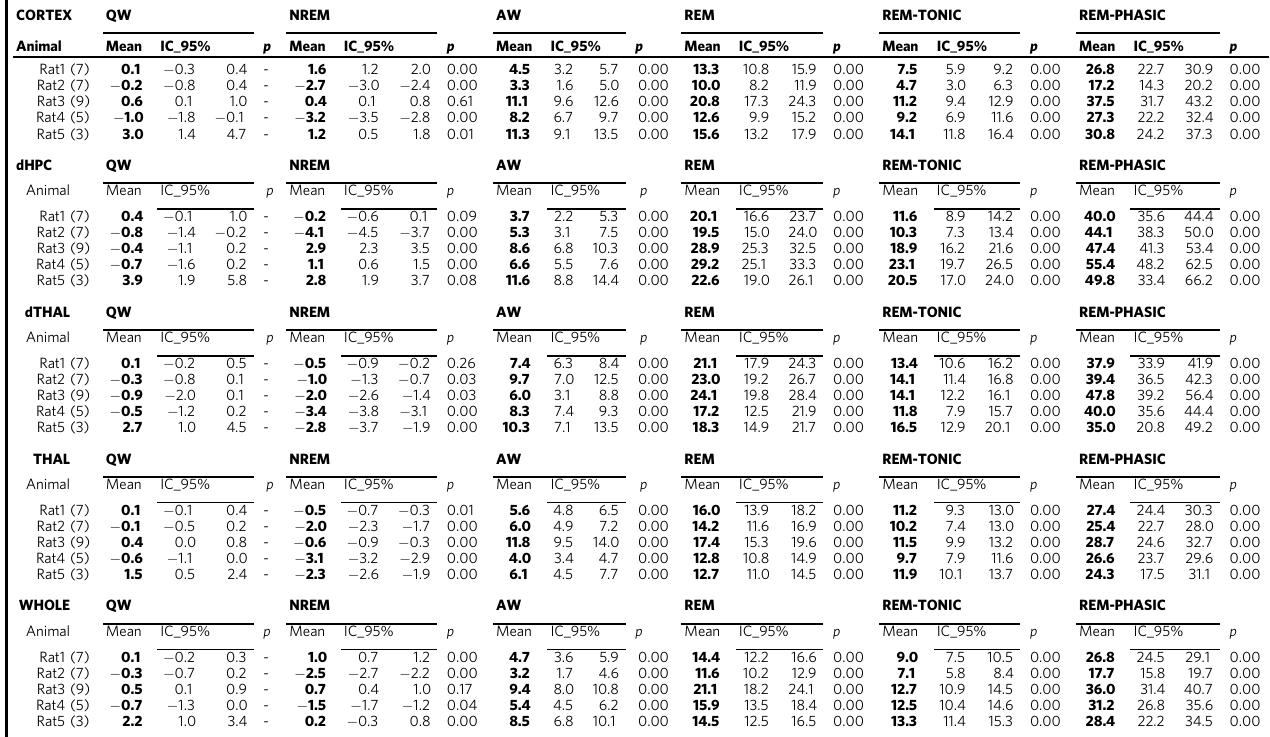
Table 2 Inter-individual analysis of CBV distributions across brain regions and sleep states CORTEX QW NREM AW REM REM-TONIC REM-PHASIC Animal Mean IC_95%